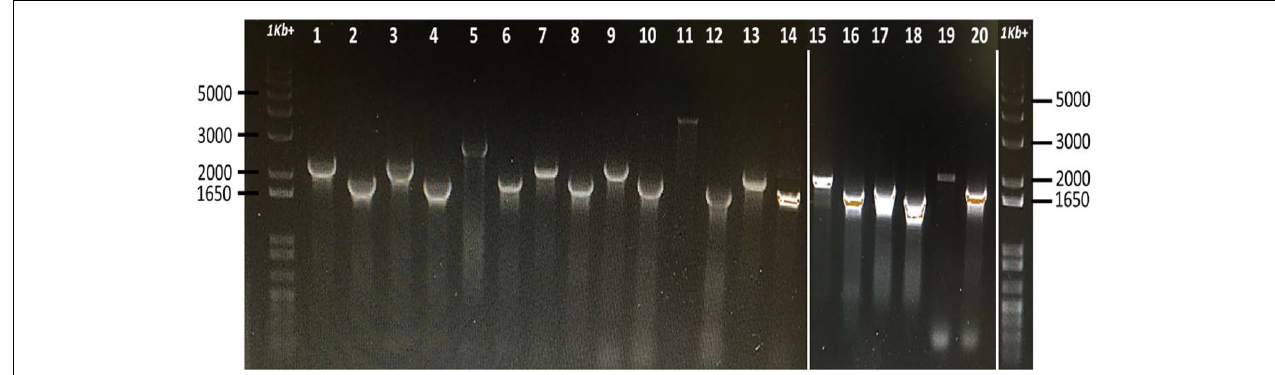
FIGURE 2 | Confirmation of E. ictaluri USP mutants by using forward (A) and reverse (D) primers. Fragments were amplified from mutant and wild-type strains and separated on two different 1% agarose gels, which were then combined (white lines above indicate joints). A 1 Kb+ marker lane was also added to the end. Lane 1, Ei WT ( usp02 ) and lane 2, Ei (cid:49) usp02 ; lane 3, Ei WT ( usp03 ) and lane 4, Ei (cid:49) usp03 ; lane 5, Ei WT ( usp 04) and lane 6, Ei (cid:49) usp04 ; lane 7 is Ei WT ( usp05 ) and lane 8, Ei (cid:49) usp05 ; lane 9 is Ei WT (usp06) and lane 10 is Ei (cid:49) usp06 ; lane 11 is Ei WT ( usp07 ) and lane 12 is Ei (cid:49) usp07 ; lane 13 is Ei WT ( usp08 ) and lane 14 is Ei (cid:49) usp08 ; lane 15 is Ei WT ( usp09 ) and lane 16 is Ei (cid:49) usp0 9; lane 17 is Ei WT (usp10) and lane 18 is Ei (cid:49) usp10 ; lane 19 is Ei WT ( usp13 ) and lane 20 is Ei (cid:49) usp13 .